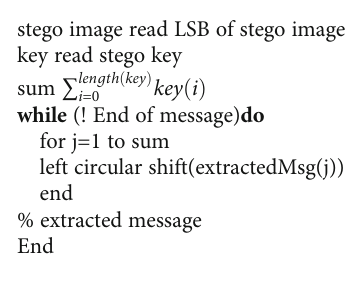
Algorithm 2: Extraction stage algorithm.